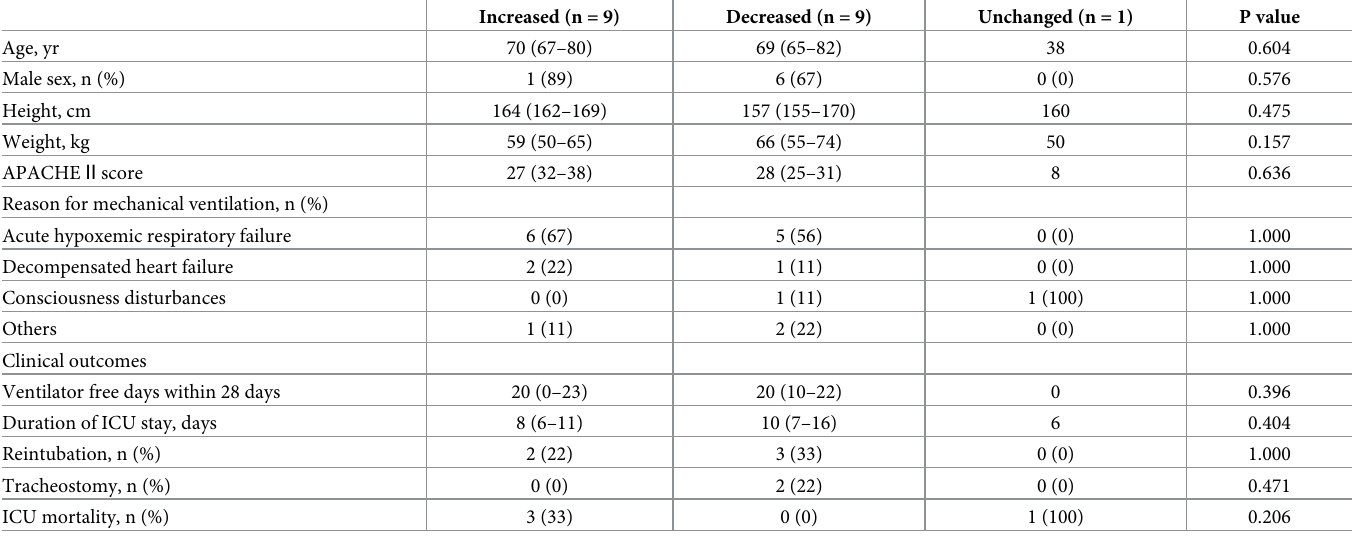
Table 1. Patient characteristics and clinical